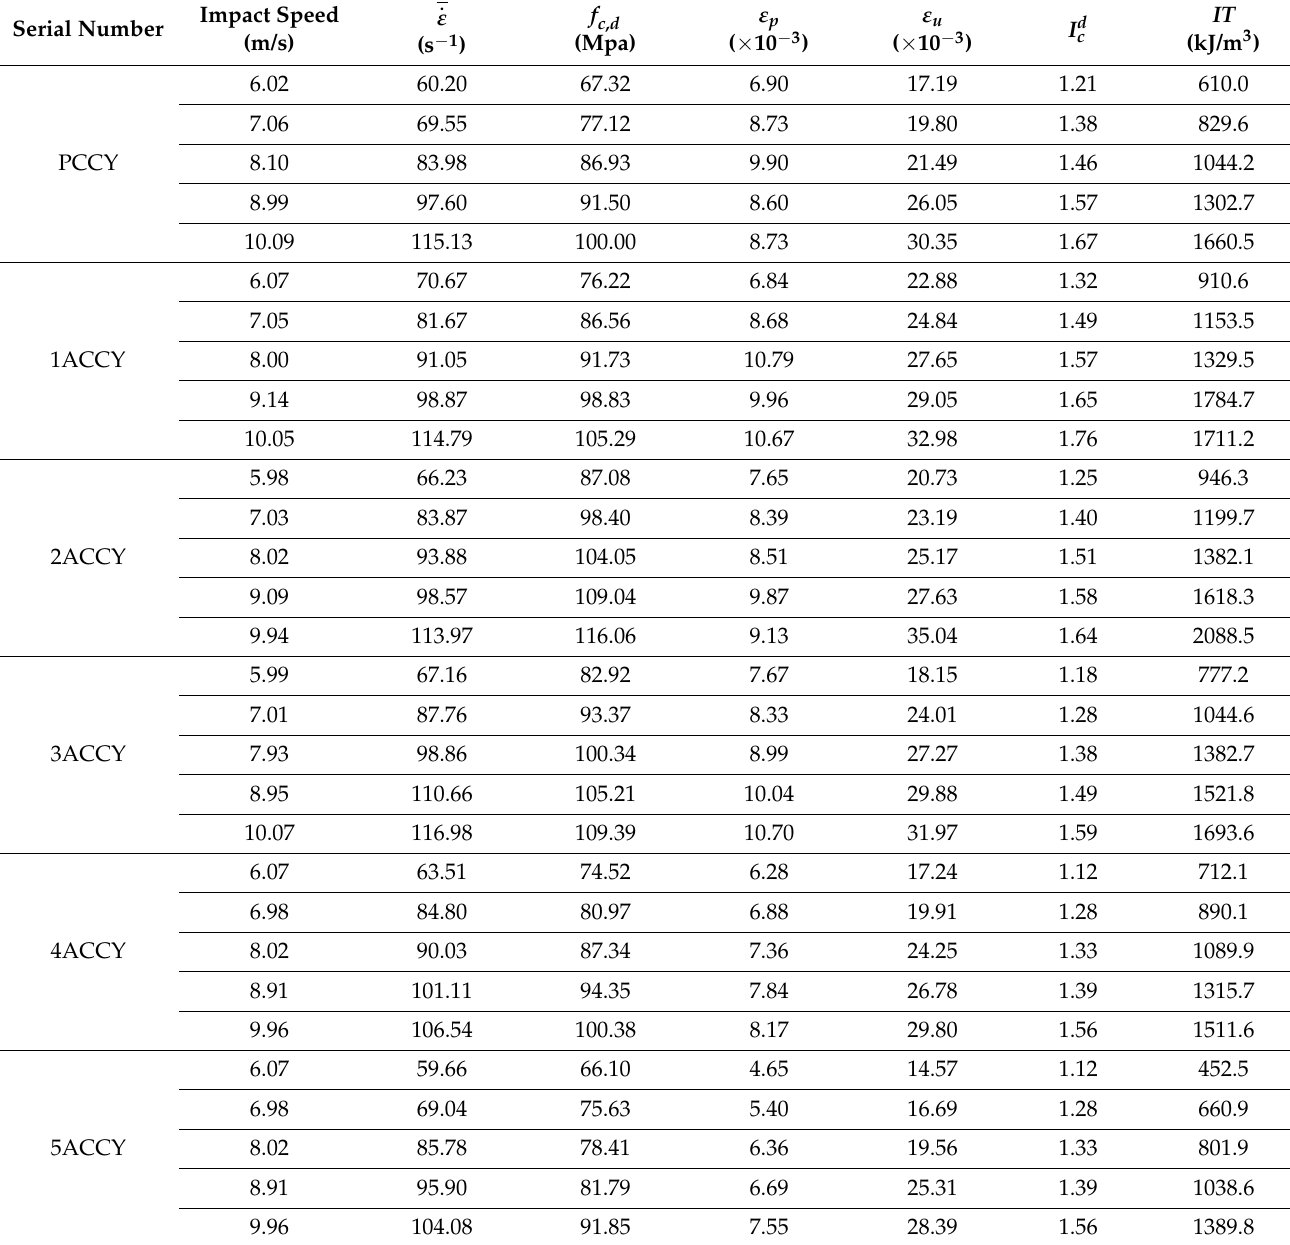
Table 3. Impact compression test results of concrete